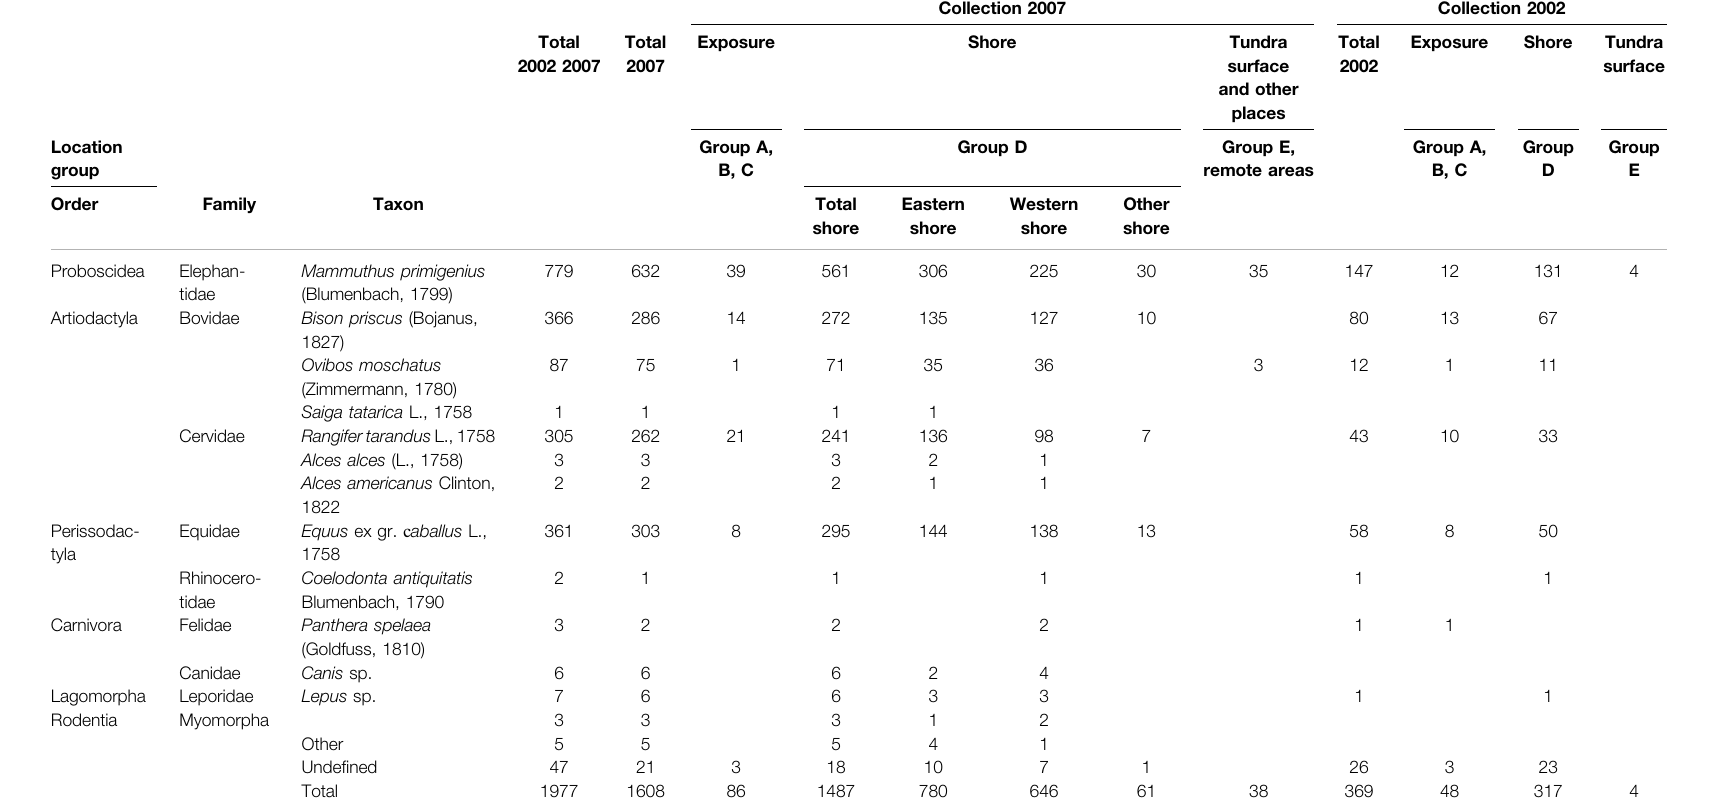
TABLE 1 | Collection of mammalian remains sampled at Oyogos Yar in 2002 and